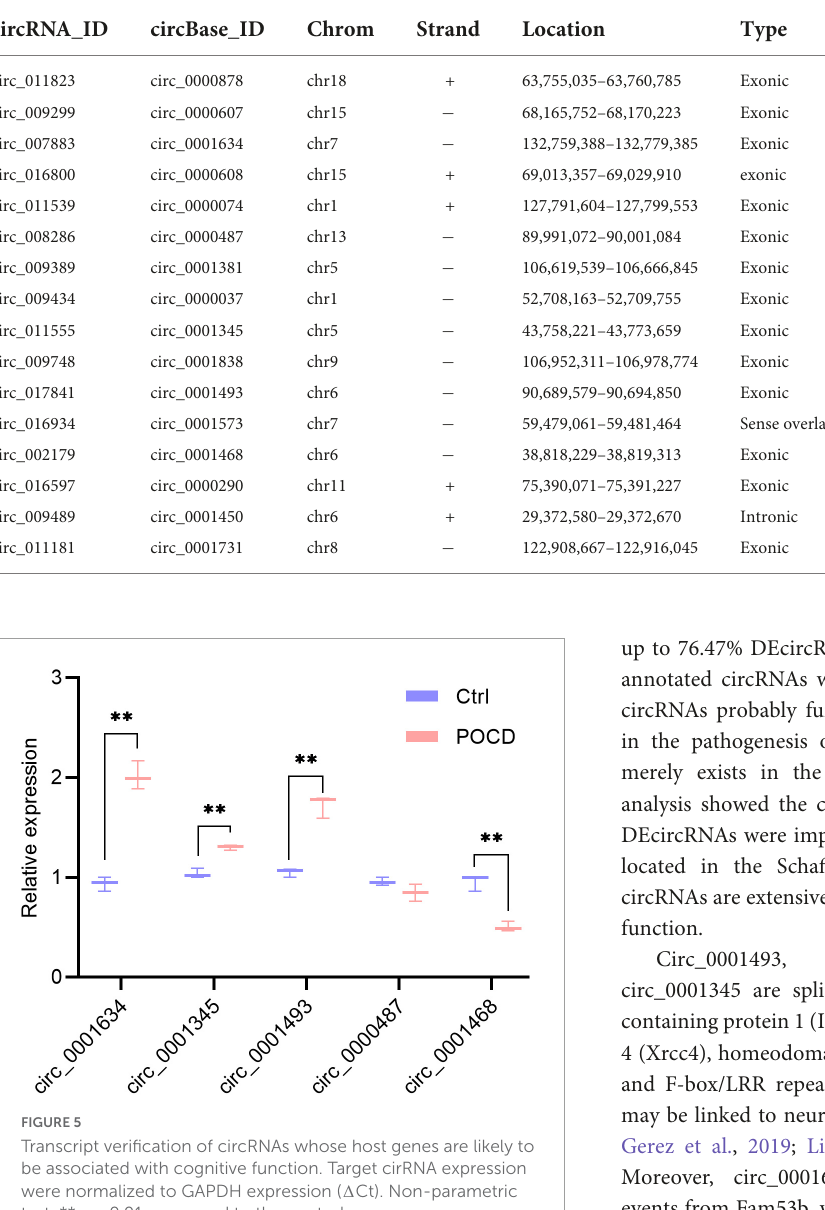
TABLE 3 Differentially expressed circRNAs annotated by circBase in POCD.